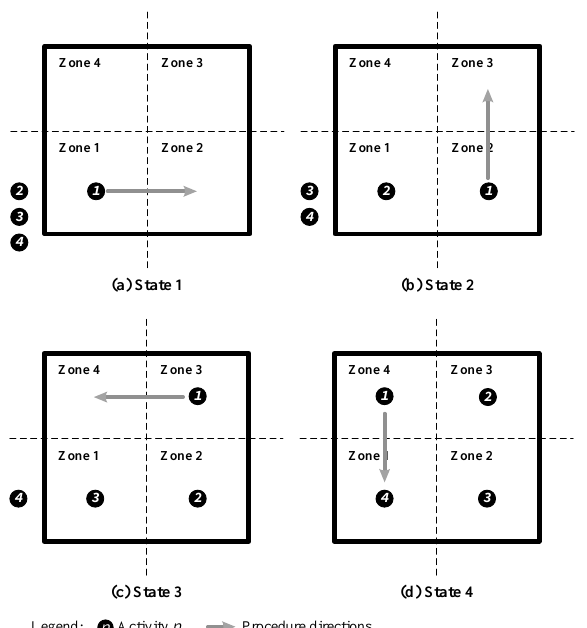
Fig. 2. Cycles of work activities by space